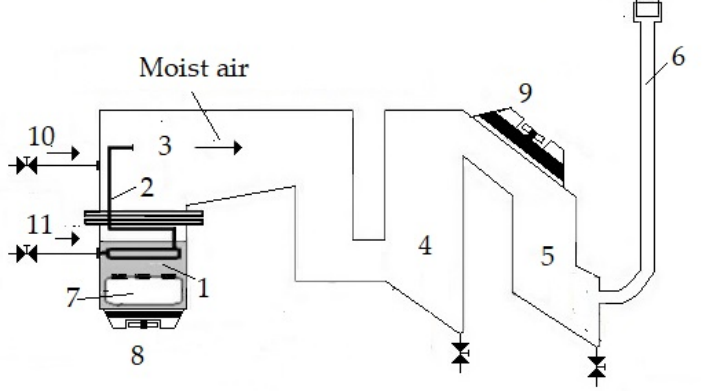
Figure 1. Schematic diagram of the bench-scale prototype used to perform boiler water treatment tests with high-frequency ultrasound waves: 1—Atomization tank; 2—Air heating coil; 3—Mixing chamber; 4,5—Condensation chambers; 6—Duct for the discharge of air; 7—Bank of transducers; 8,9—Coolers; 10—Raw water entrance; 11—Atmospheric air entrance